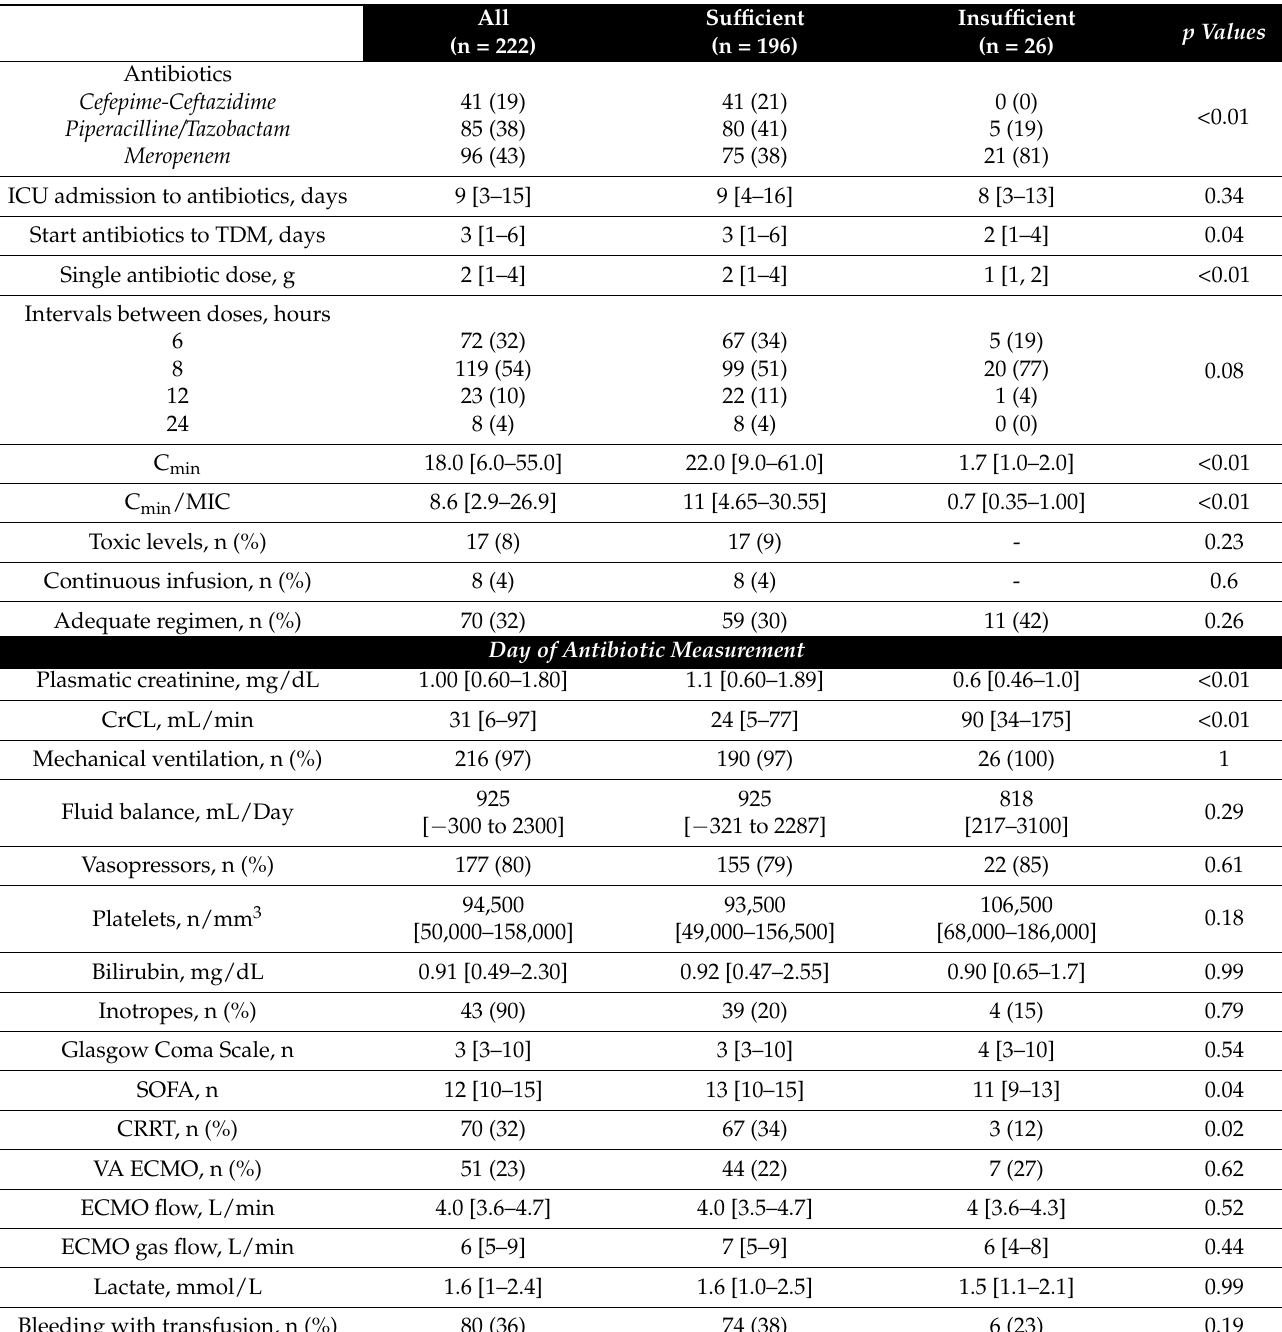
Table 3. Differences between therapeutic drug monitoring (TDM) with and without insufficient drug concentrations. Data are presented as count (%) or median (25th–75th percentiles). ICU = intensive care unit; Cmin = minimum blood plasma concentration; MIC = minimal inhibitory concentration; CrCL = creatinine clearance; SOFA = Sequential Organ Failure Assessment; CRRT = continuous renal replacement therapy; VA = veno-arterial; ECMO = extra-corporeal membranous